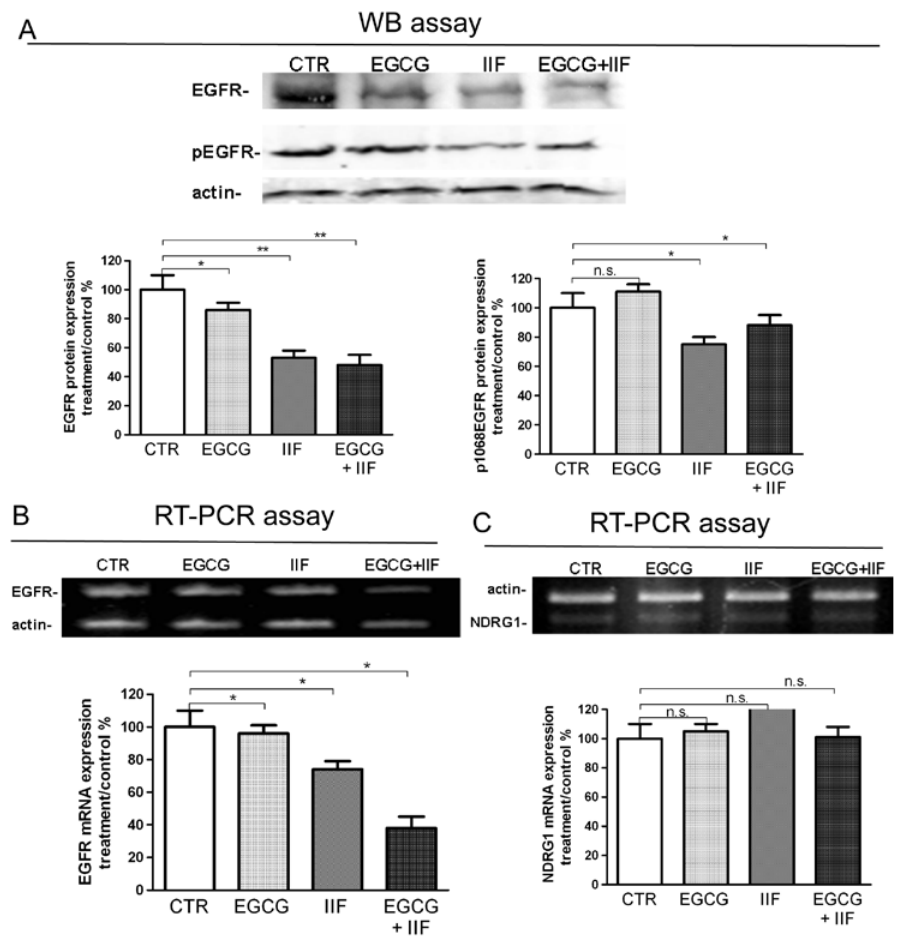
Figure 6. Downregulation of EGFR and p1068EGFR expression by EGCG and IIF treatments in BE(2)-C neuroblastoma cells. Cells were treated with 20 µ g/mL EGCG and 10 µ M IIF, individually and in combination for 24 h. ( A ) Proteins (50 µ g) from total cell lysate were subjected to SDS–PAGE and Western blot analysis of EGFR and p1068EGFR expression after 24 h treatments. Actin was used as a loading control. RT-PCR analysis of EGFR ( B ) and NDRG1 ( C ) in control and treated cells. β -actin was used as a control. The values were normalized to the untreated controls. The results are expressed as the average ± SE of three independent experiments. * p < 0.05; ** p < 0.01. n.s.: not significant. WB: western blot; RT-PCR: reverse transcriptase-polymerase chain reaction.